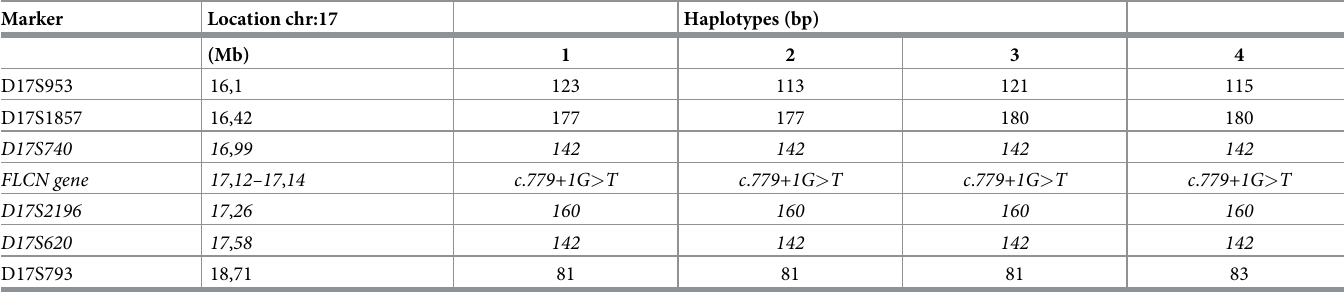
Table 2. Haplotype analysis in families carrying the c.779+1G > T variant in the FLCN gene. The shared haplotype is marked with italic and spans at least 0,58Mb up to 2,30Mb.